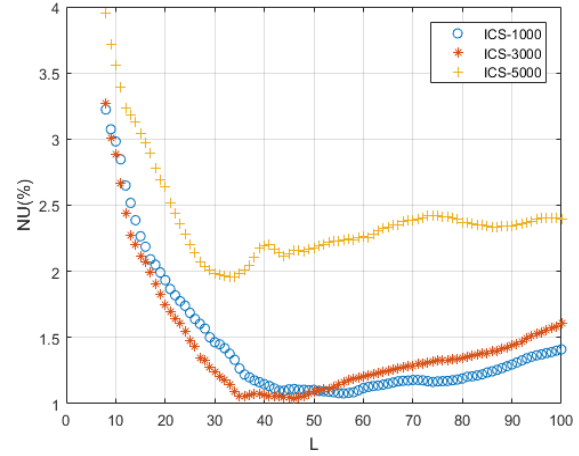
Figure 11. NUC results of the algorithm with various filtering kernel function lengths L on the test image shown in Figure 10a.